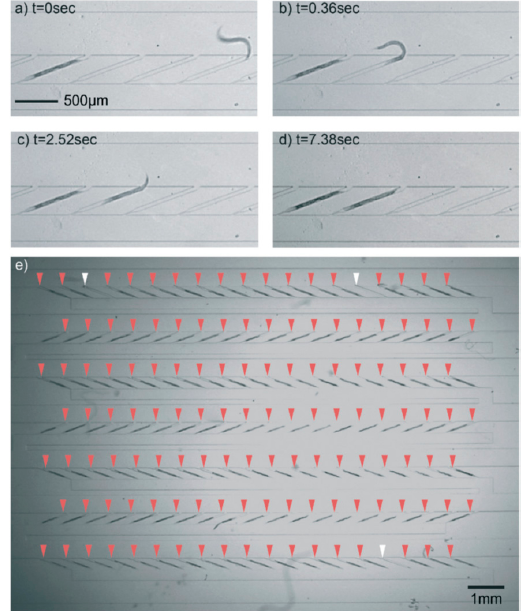
Figure 6. A magnified view of an array of microfluidic channels and immobilized worms from the device shown in Figure 5. ( a – d ) The crawling and subsequent immobilization of worm in the microchannels at successive time points; ( e ) an array of immobilized worms in microchannels, indicated by red arrowheads, and empty channels, indicated by white arrowheads. Reprinted with permission from the Royal Society of Chemistry.